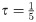
Cubic Bezier curves with lower and higher spatial sampling intervals.The left panel (a) shows τ=15, while the right panel (b) shows τ=150 (control points are not shown).